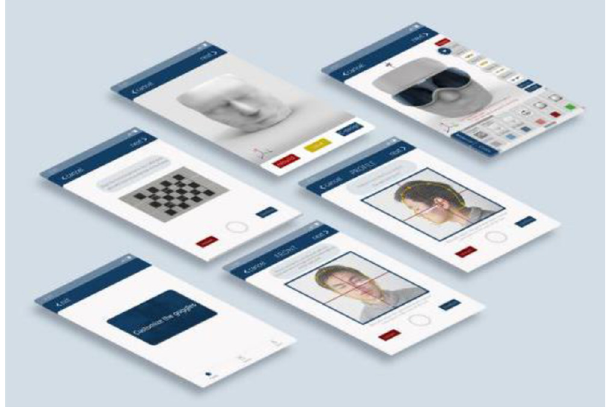
Fig. 20. Personal design APP for swimming goggles.